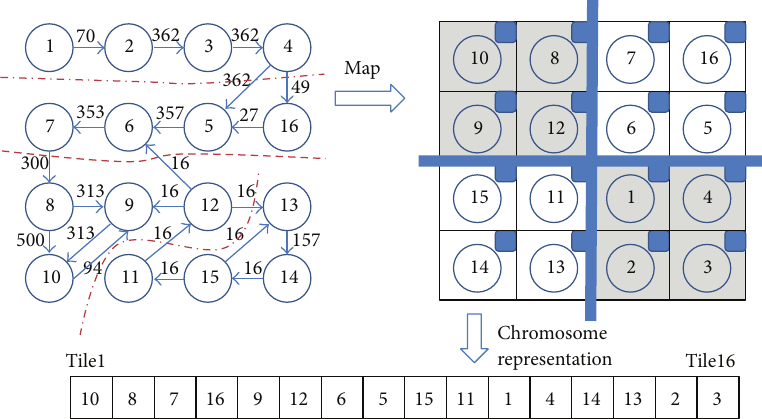
Figure 2: Encoded chromosome for VOPD application [10] based on 4 × 4 mesh topology